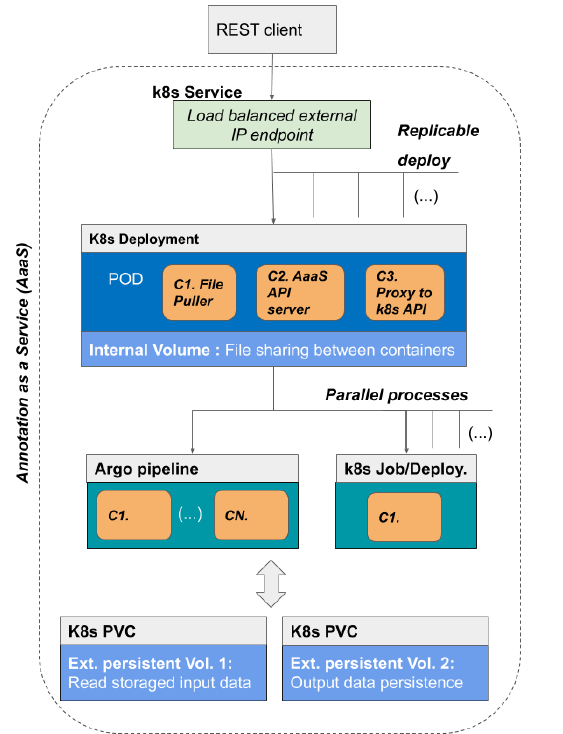
Figure 2. Proposed architecture to integrate annotation workflows as containerized applications for AaaS. It is composed by several Kubernetes workloads for managing and running the containers at scale on an agnostic Kubernetes